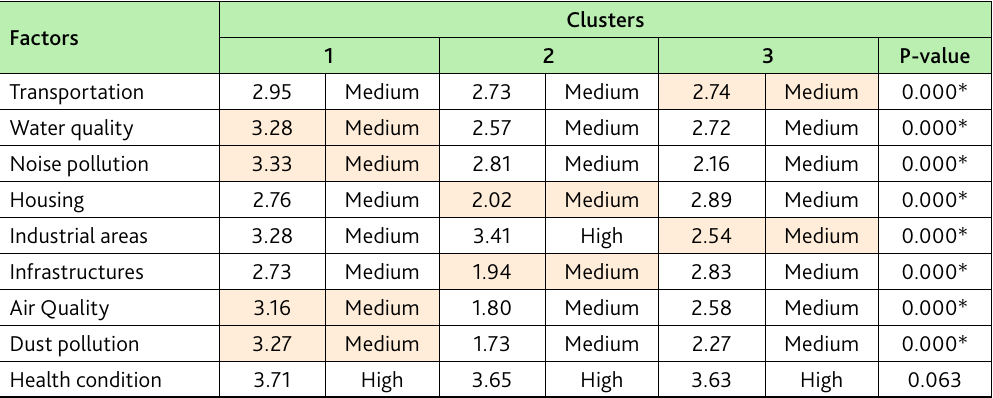
Table 2. Classification of different the built environmental factors and health impacts Factors